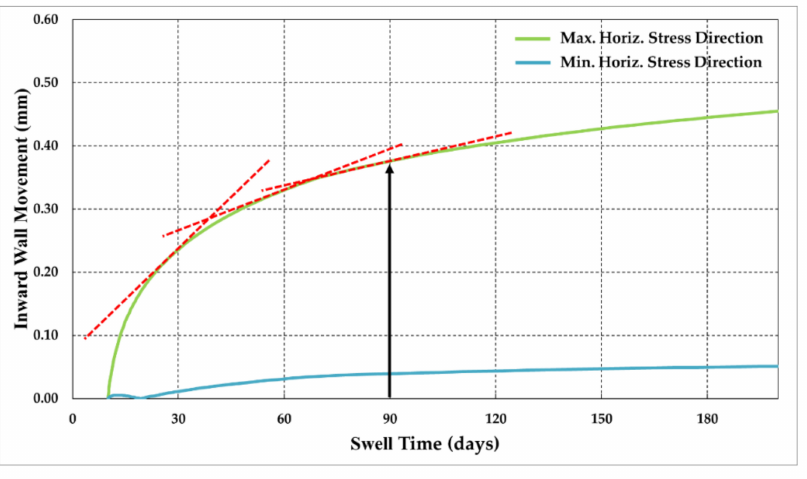
Figure 9. The convergence of the excavation boundaries up until the installation of the shaft wall (90